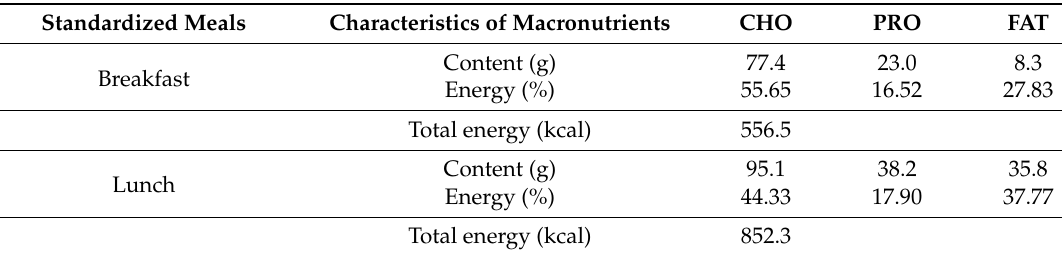
Table 3. Composition of macronutrients in standardized meals.